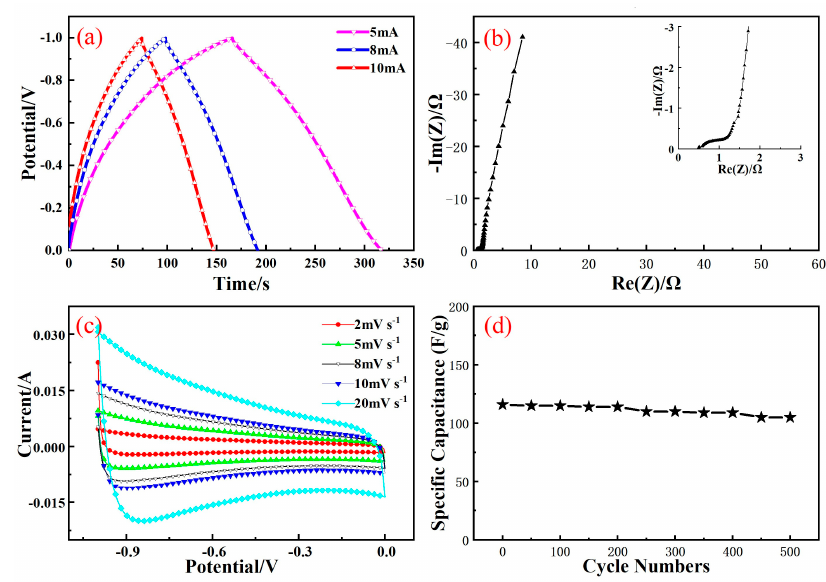
Figure 4. Electrical performance test: (a ) Charge–discharge curves; ( b ) Impedance characteristic curves; ( c ) CV curves; ( d ) Cycle performance curves.